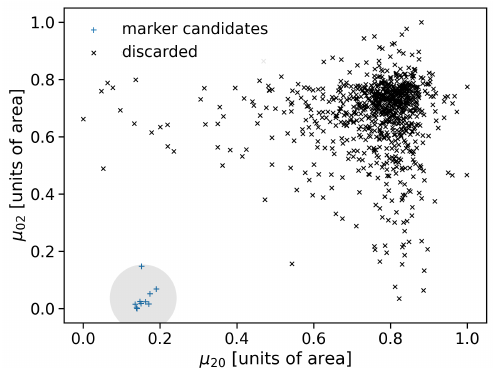
Figure 6. Normalized second order central image moments calculated for a marker-sized local area around marker candidates in the original MRI. Moments are calculated in three dimensions but plotted in two dimensions for visualization purposes. K-Means clustering was applied in order to distinguish false positive clusters from true markers. The cluster of marker candidates is highlighted by a circle around the clusters centroid.